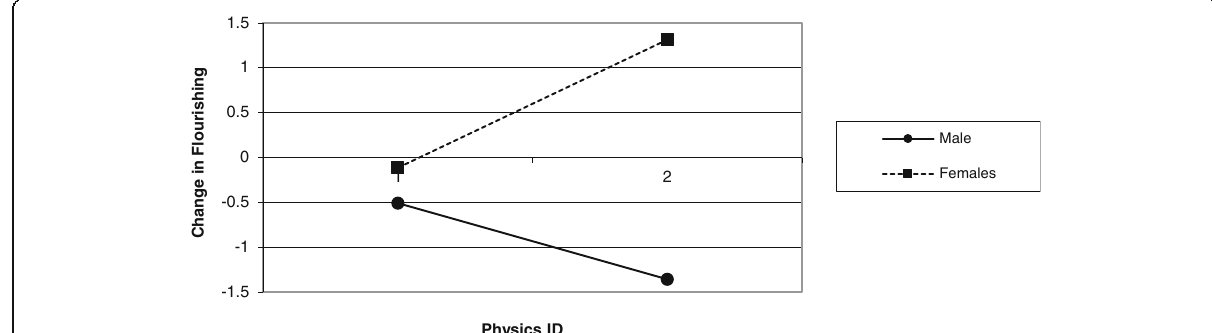
Fig. 2 Changes in flourishing over the course of the term based on physics identification for males and females. Positive numbers for flourishing indicate positive change for flourishing. Negative numbers indicate a negative change for